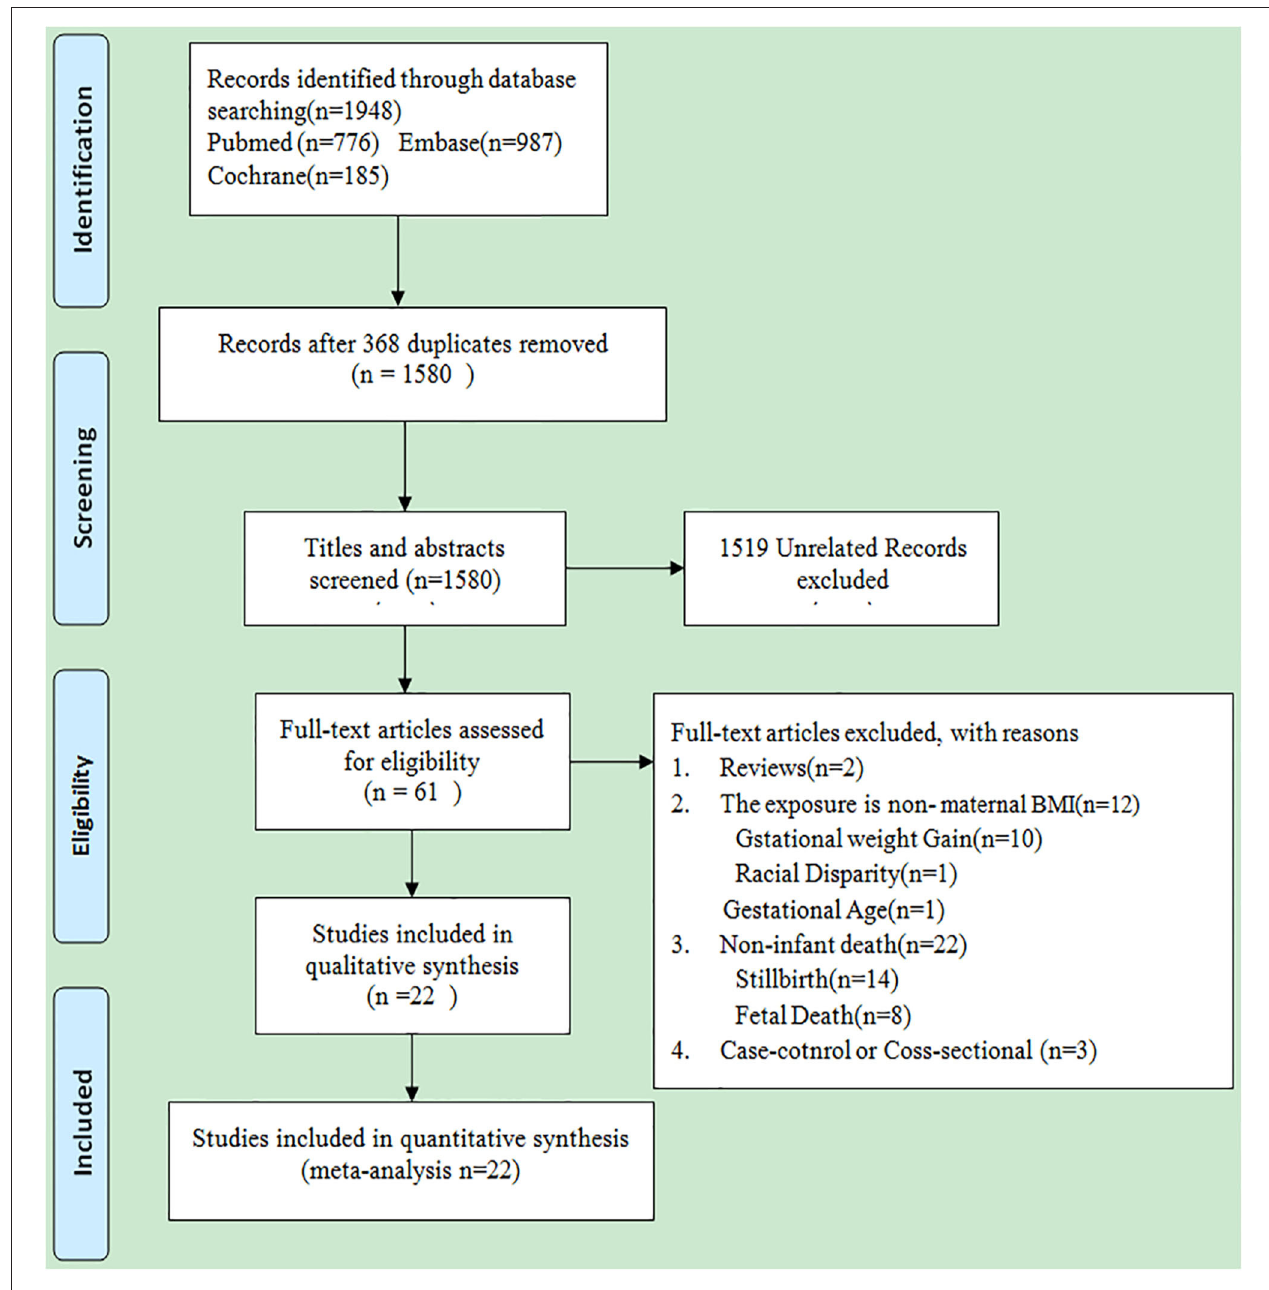
FIGURE 1 | Flow chart of the study retrieval